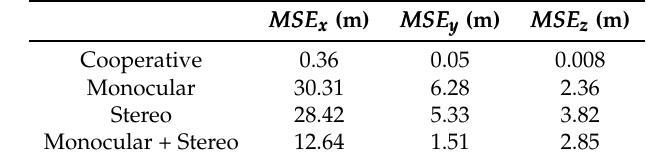
Table 2. Mean squared error in the position estimation.